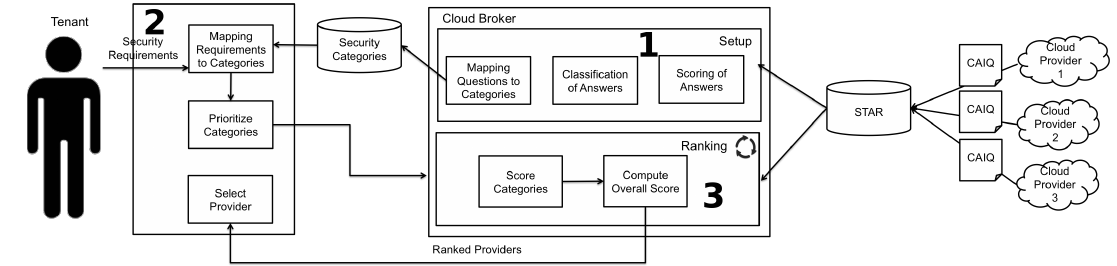
Figure 6. Security-Aware Cloud Provider Selection Approach.